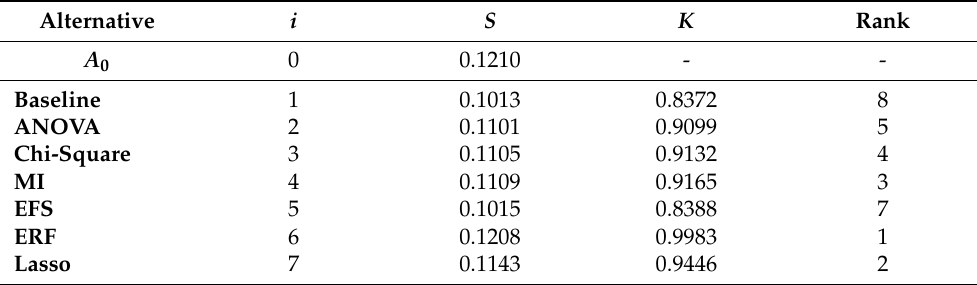
Table 7. The result of optimality value on the feature selection methods.